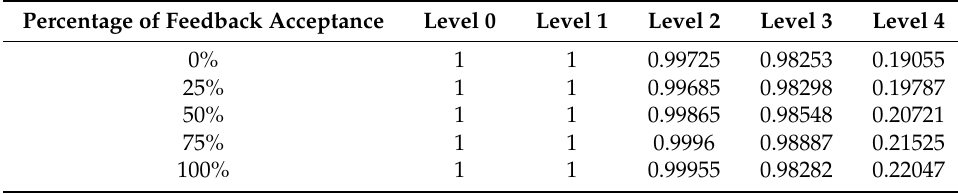
Table 9. User trust levels concerning autonomy when there is a high error rate at level 3 and the user is